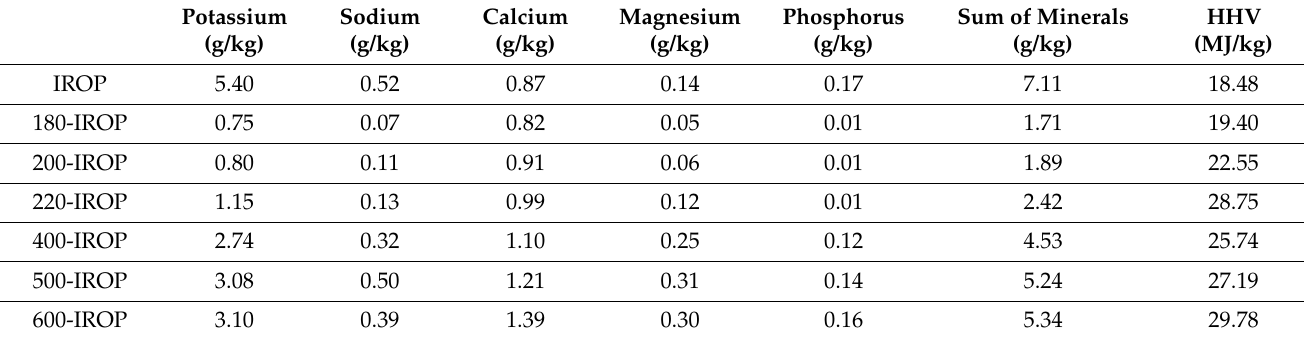
Table 2. Elemental composition (db.%) and HHV (MJ/kg) of IROP hydrochars and biochars produced at different